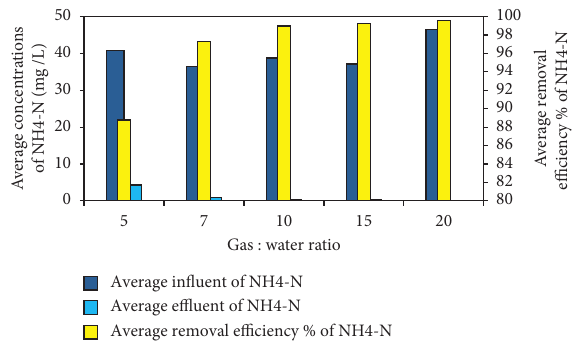
Figure 8: Effect of gas :water ratio on the average NH 4+ -N removal.